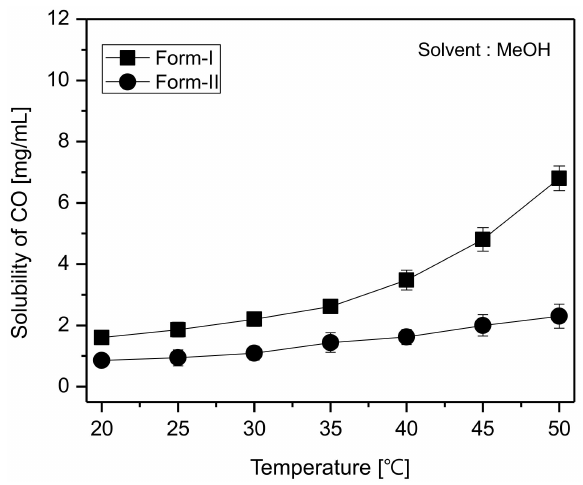
Figure 9. Solubility of CO form-I and form-II in MeOH.